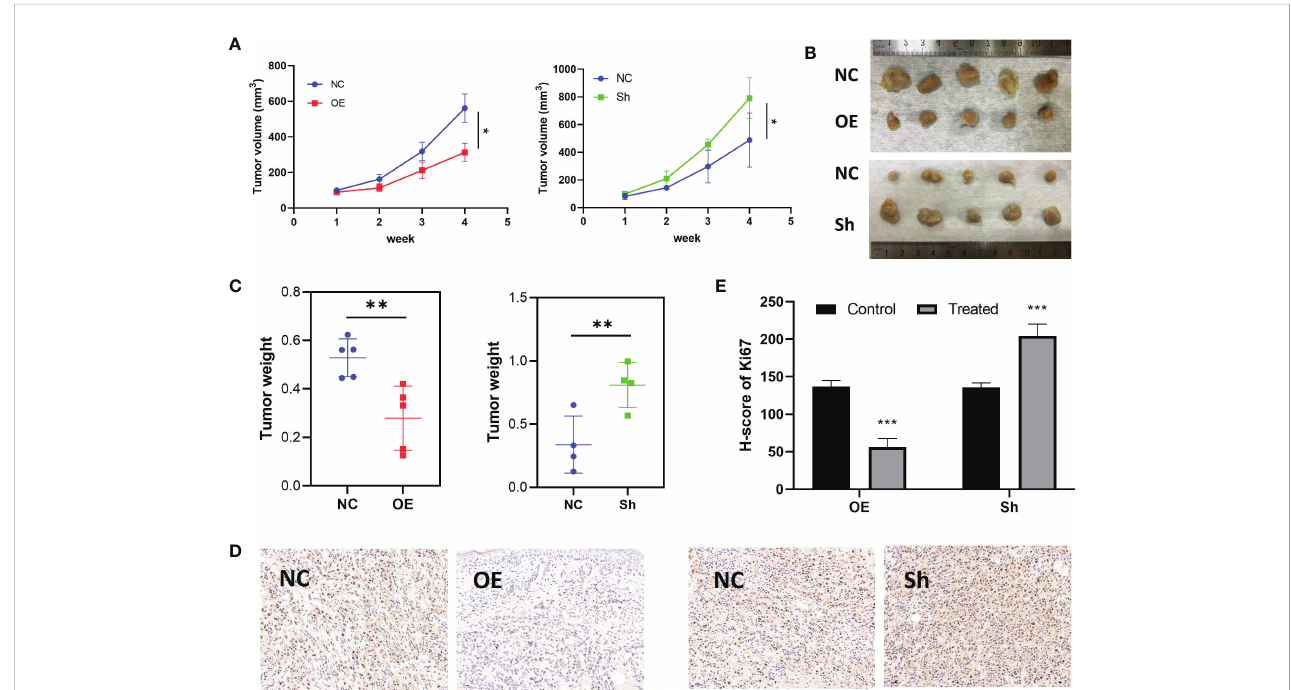
FIGURE 3 RPS6KA2 inhibited the growth of ovarian cancer in vivo . (A) Tumor growth curves in each group. (B) Pictures of tumors which were formed in nude mice. (C) Tumor weights in each group. (D) Ki67 staining was detected in ovarian cancer subcutaneous xenograft model by IHC. (E) H-score of Ki67 staining. (* indicates p<0.05, ** indicates p<0.01, *** indicates